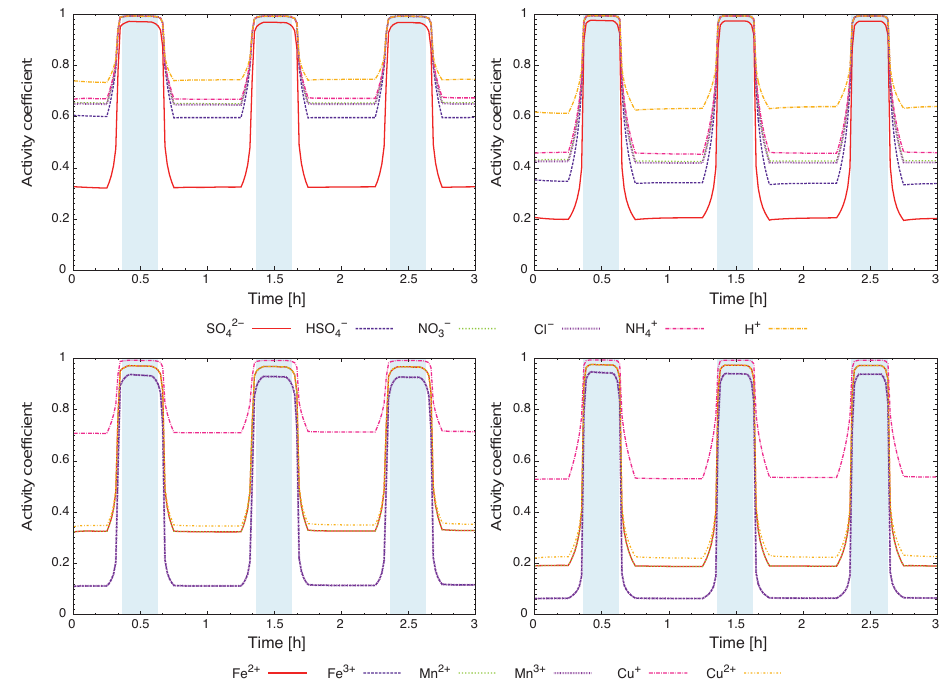
Figure 12. Modeled activity coefficients of main inorganic particle-phase constituents (top) and important transition metal ions (TMIs, down) as the function of the simulation time for the two different relative humidity cases (left: 90%RH; right: 70%RH). The blue bars mark the in-cloud time periods during the simulation